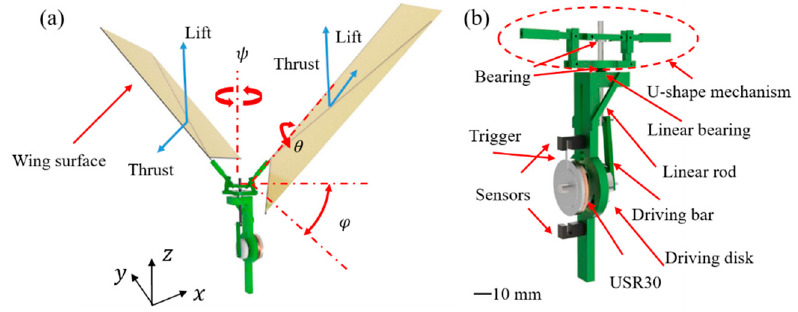
Figure 1. ( a ) Working principle; ( b ) driving mechanism of the flapping wing rotor.